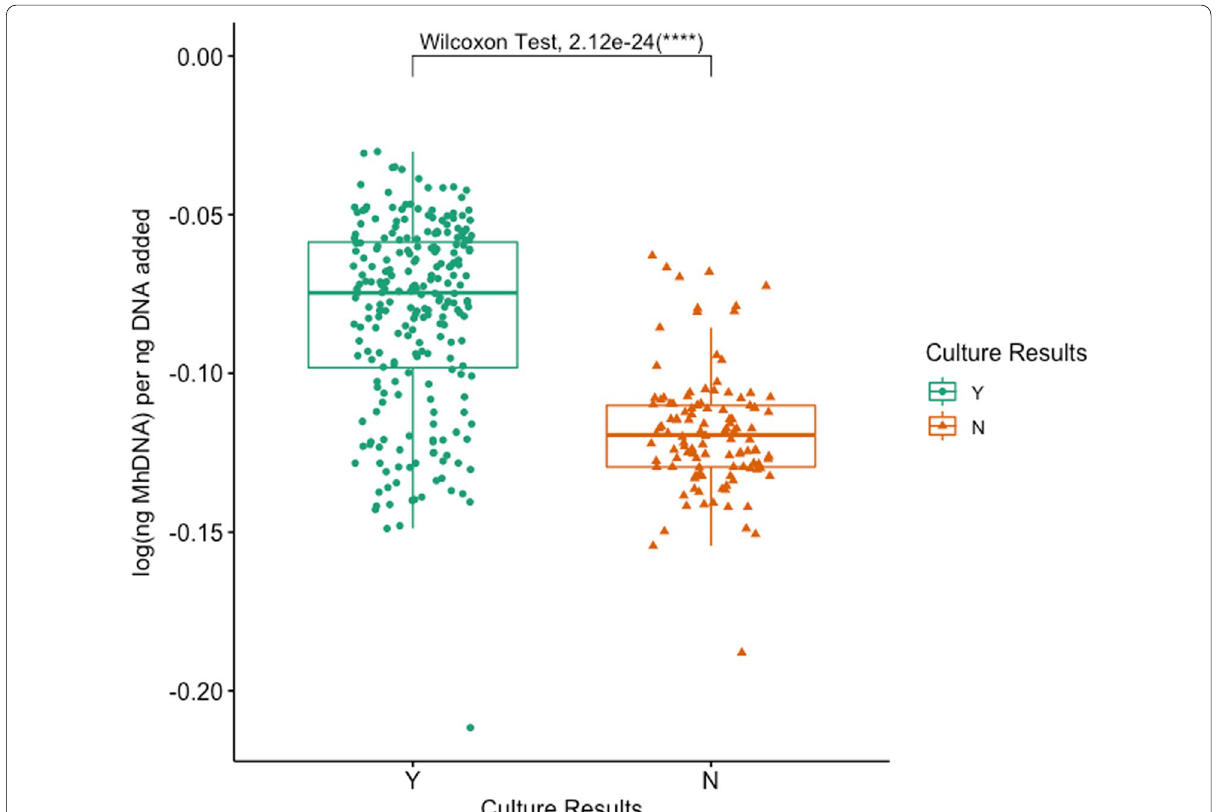
Fig. 4 Box and whisker of log(ng Mh DNA) per ng DNA added vs. culture results (Wilcoxon rank-sum test, P <